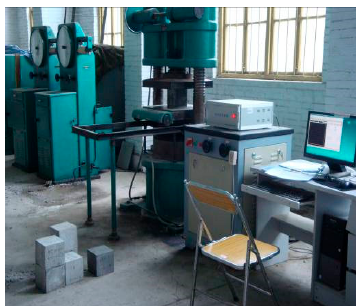
Figure 2. HYY electro-hydraulic servo material test system.